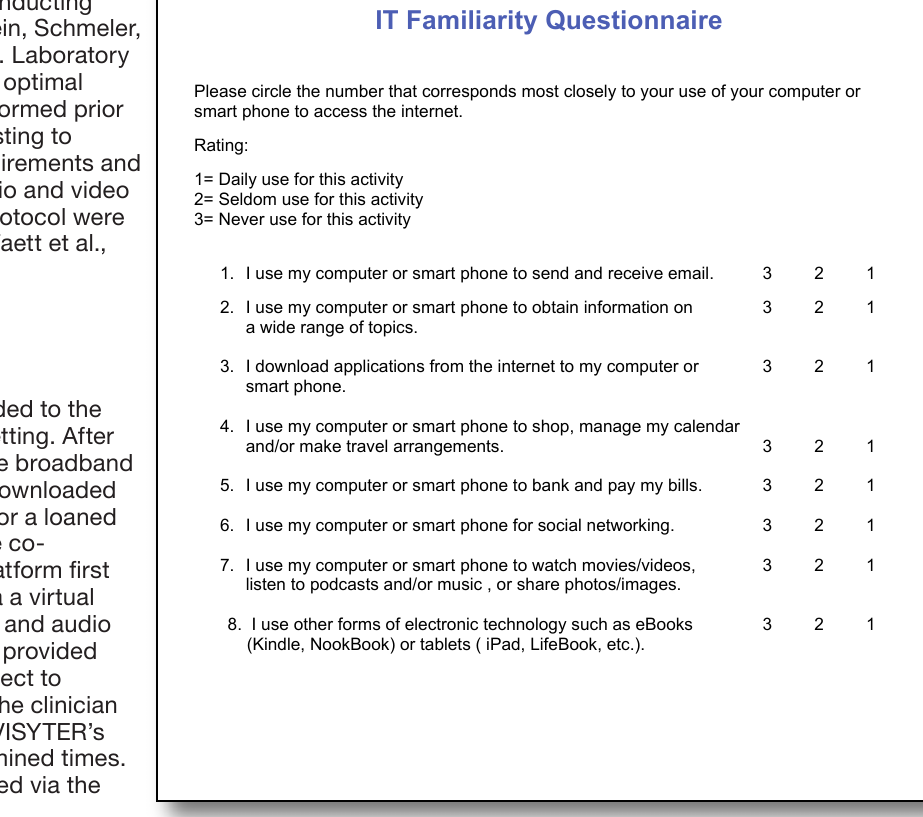
Figure 1. IT Familiarity Questionnaire (Geyer, M.